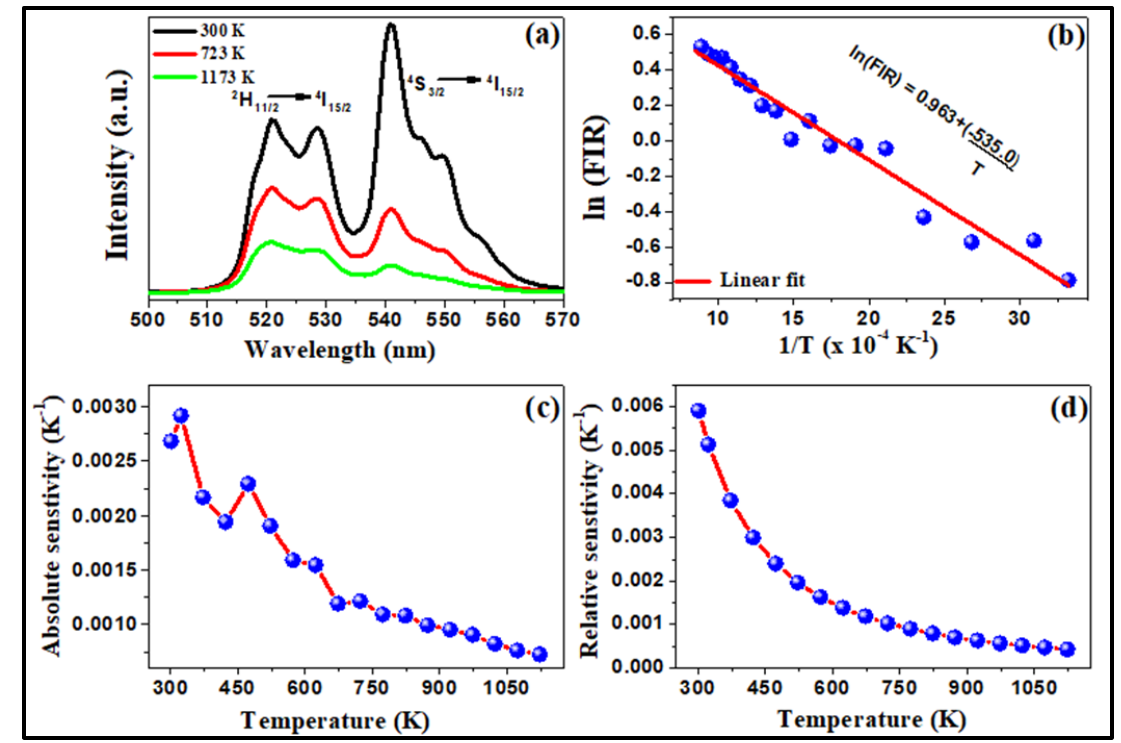
Figure 8. Temperature sensing behavior of NaGdF 4 : Er 3+ /Yb 3+ upconversion phosphor particles sampled at low power excitation of 500 mW. ( a ) Samples surrounding temperature-dependent upconversion emission intensity variations at different selected temperatures; ( b ) ln (FIR) with the function of inverse temperature; ( c ) variation of absolute sensor sensitivity with temperature; ( d ) variation of relative sensor sensitivity with temperature.